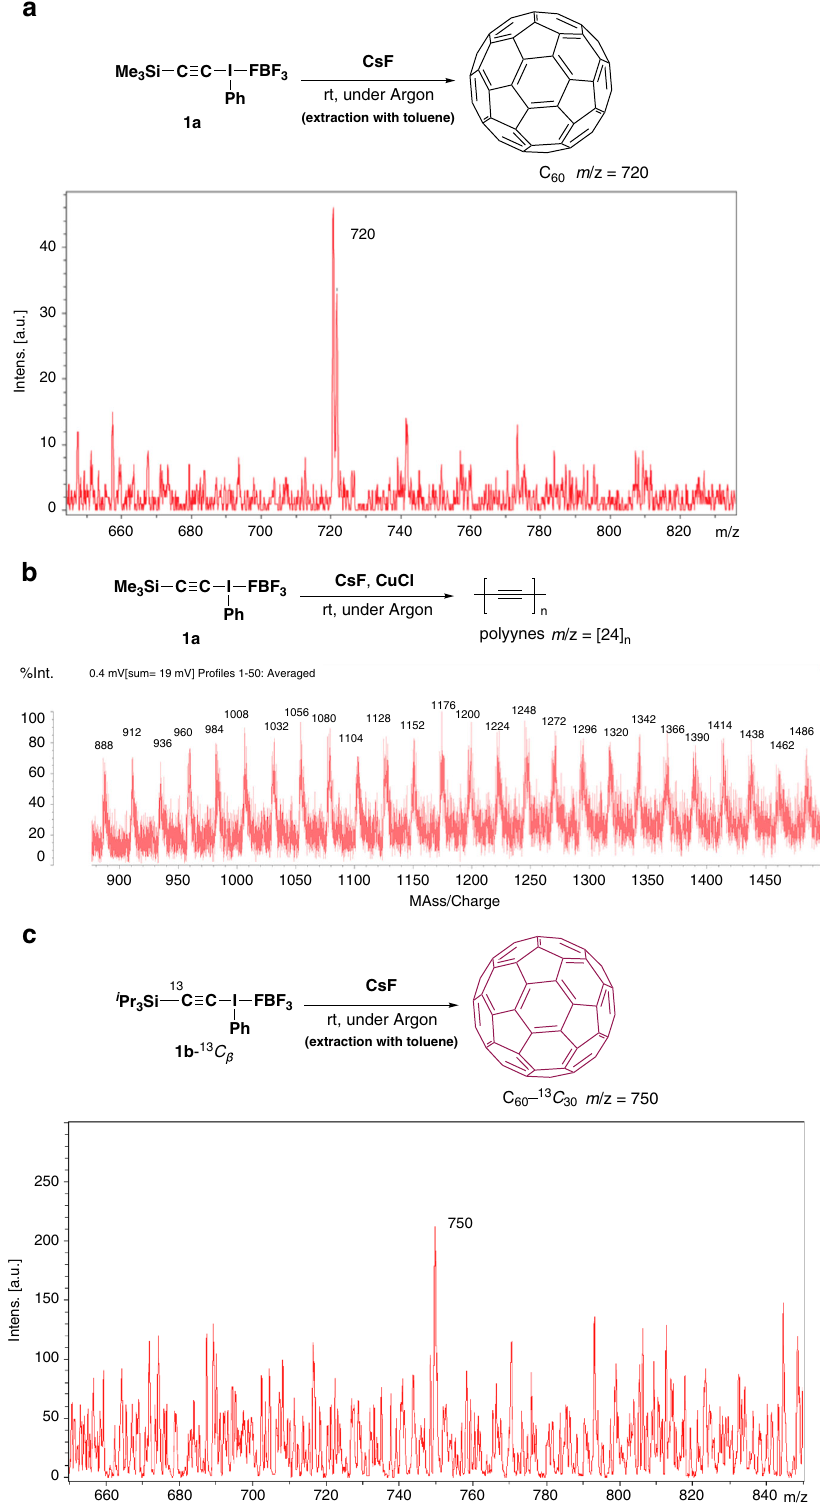
Fig. 3 Solvent-free reaction of in situ generated C 2 in a mortar at room temperature leads to spontaneous formation of carbon allotropes. MALDI-TOF mass spectra of a Ground 1a and CsF. b Ground 1a and CsF in the presence of CuCl (1.0 equiv). c Ground 1b - 13 C β and